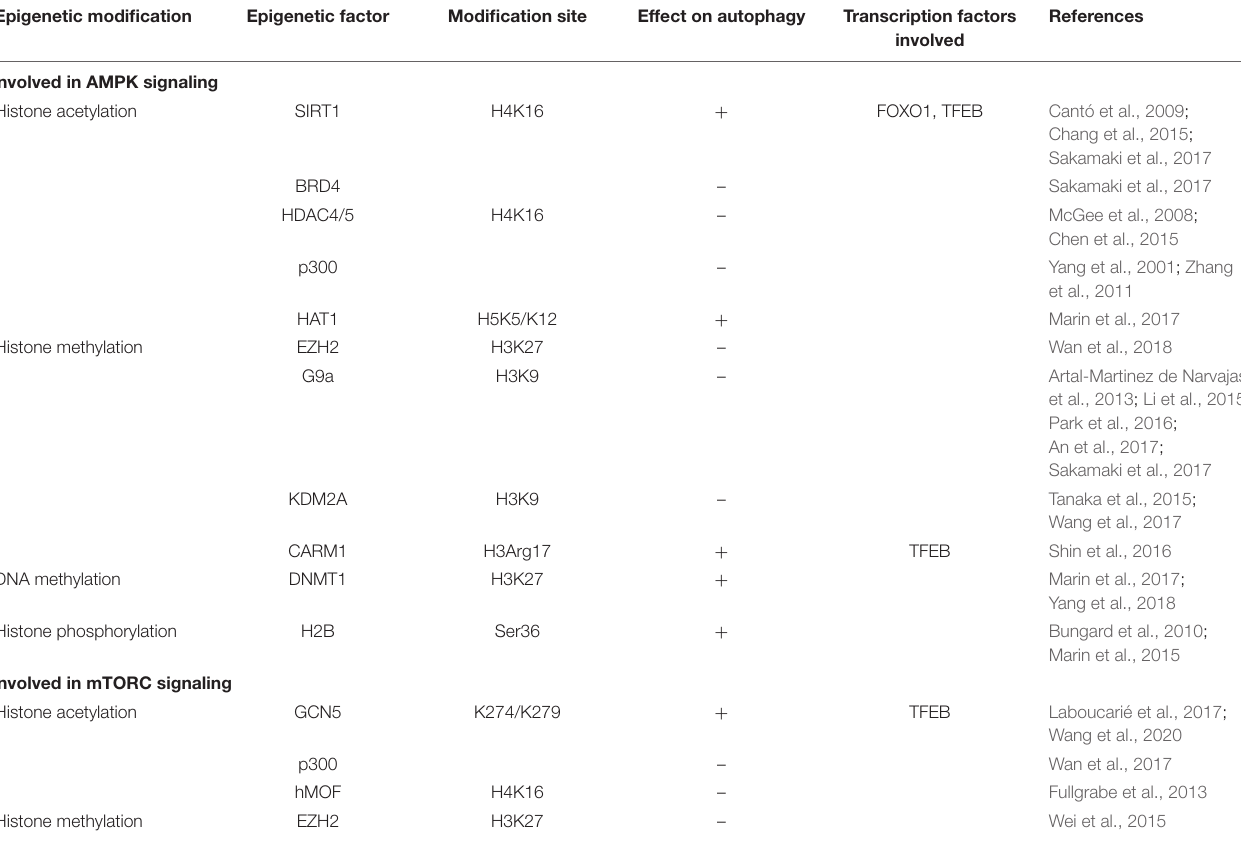
TABLE 2 | Epigenetic factors involved in autophagy